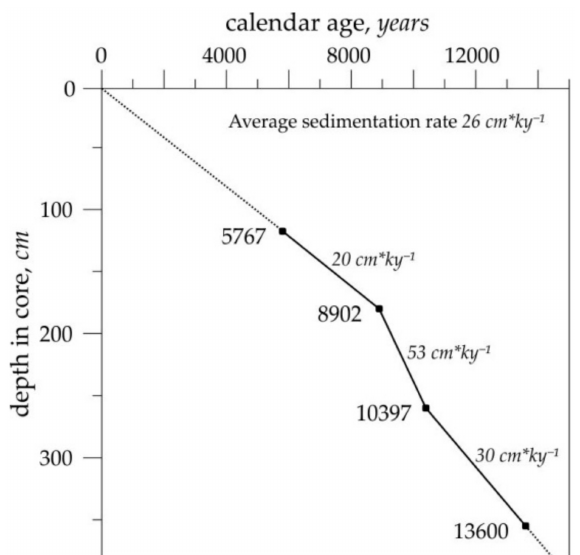
Figure 2. Age–depth plot for the core AMK-340 based on the AMS (Accelerator Mass Spectrometry) 14 C-datings converted to the calendar ages (black squares). Sedimentation rates are displayed. The surface is assumed modern and given a 0 kyr